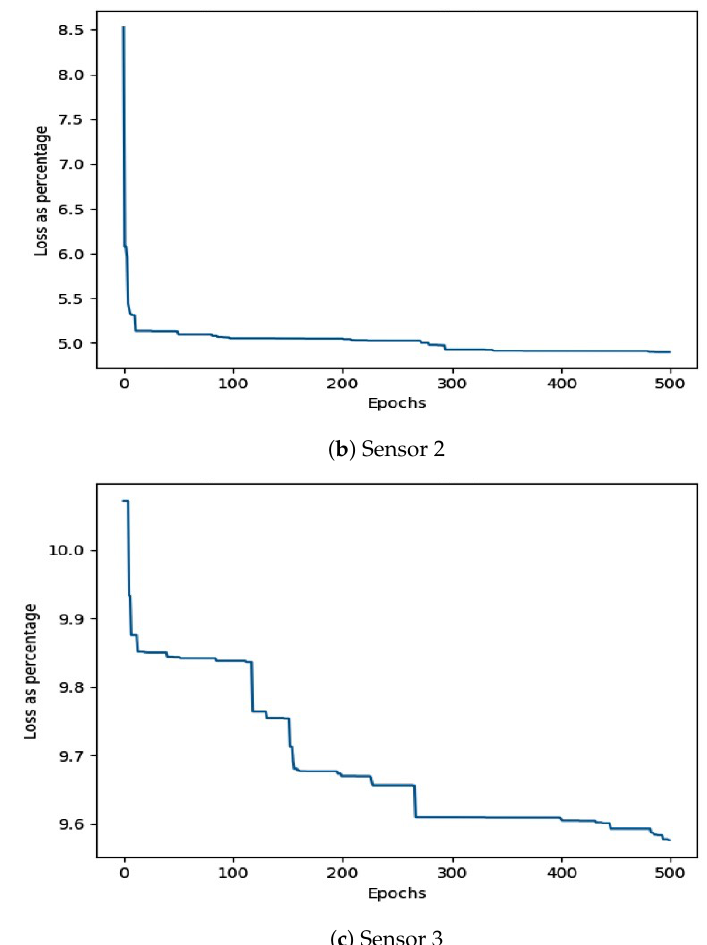
Figure 6. Training loss of the MLP over 500 epochs.